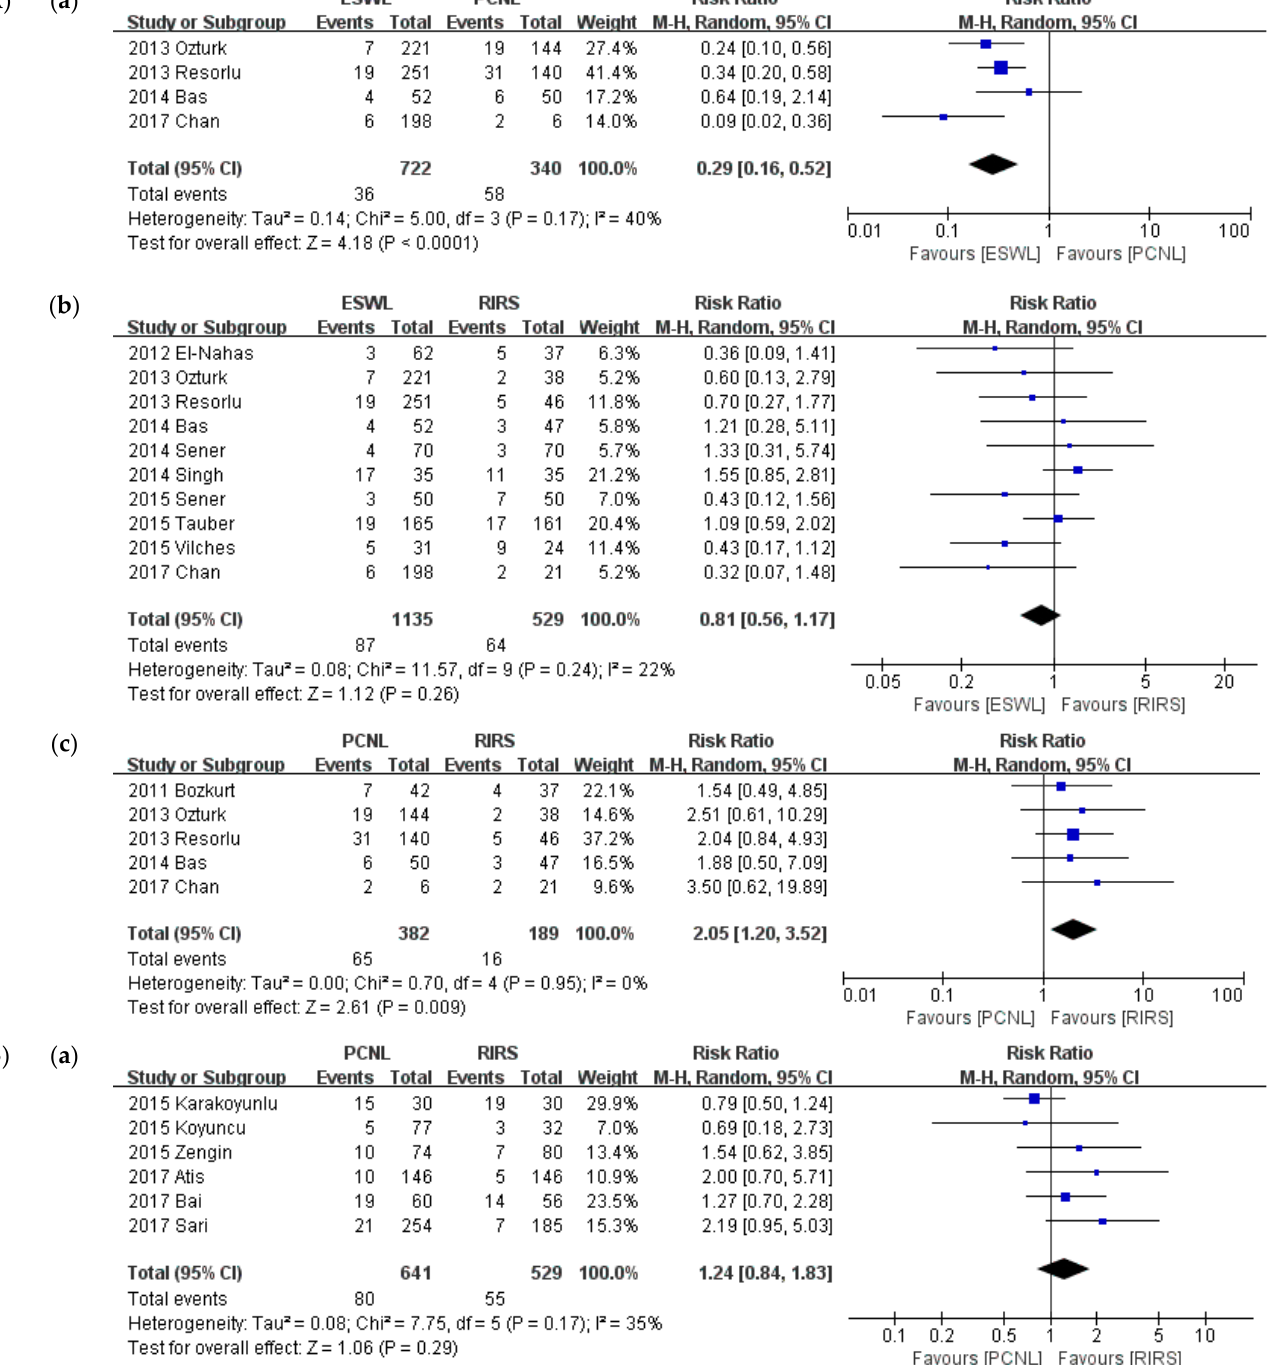
Figure 5. Meta-analysis of total complications: ( a ) ESWL vs. PCNL; ( b ) ESWL vs. RIRS; and ( c ) PCNL vs. RIRS. Sub-group analysis was conducted on the criterion of 2-cm stone diameter. A com- parison of SFRs is shown in Figure 6. In the group of stones smaller than 2 cm, like in the primary analysis, ESWL resulted in fewer complications than PCNL ( p < 0.001; RR = 0.29;